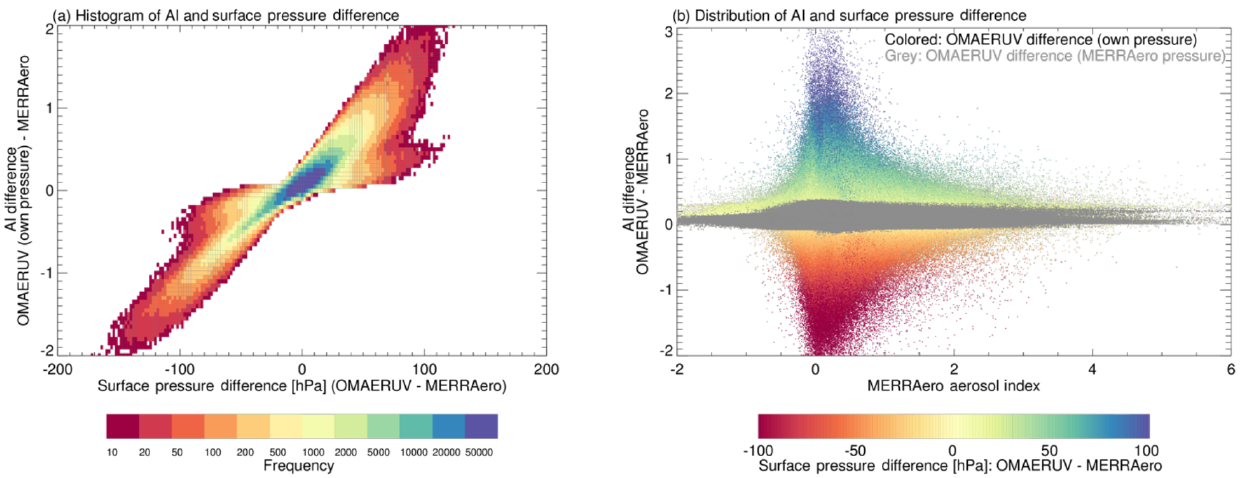
Figure 2. (a) Frequency distribution of OMAERUV AI–MERRAero AI differences vs. OMAERUV–MERRAero surface pressure differ- ences for all pixels in June 2007. (b) OMAERUV AI–MERRAero AI difference as function of the MERRAero AI for all pixels dur- ing June 2007. Colored points are for AI difference when OMAERUV uses its own surface pressure, with the coloring indicating the OMAERUV–MERRAero surface pressure difference. Grey points are for the AI difference residual when OMAERUV calculates AI using the MERRAero surface pressure.